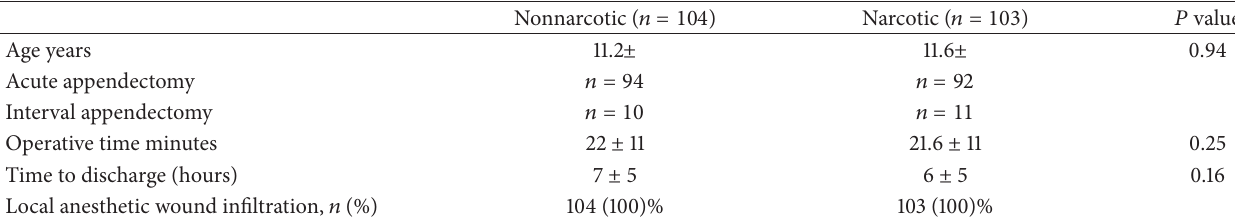
Table 1: Demographics and operative details.